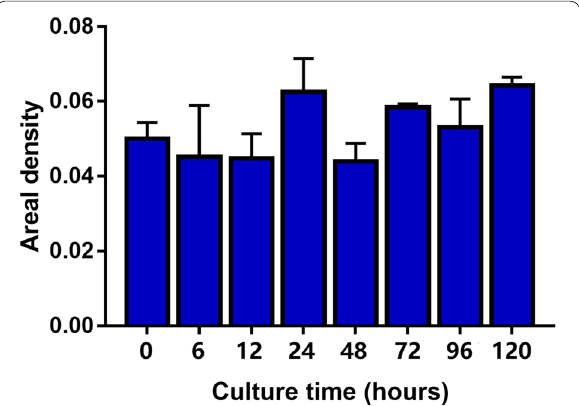
Fig. 6 The areal density (AD) values of 10H8-stained Candida albicans blastospores at different culture time points in YPD